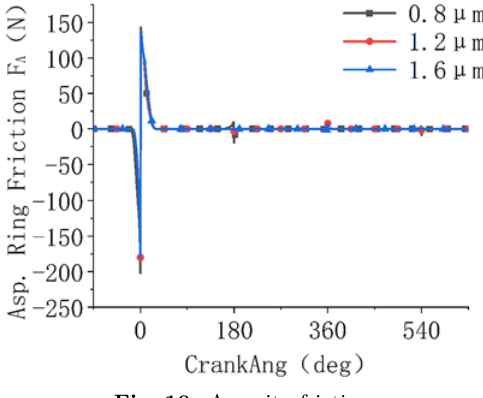
Fig. 10. Asperity friction.